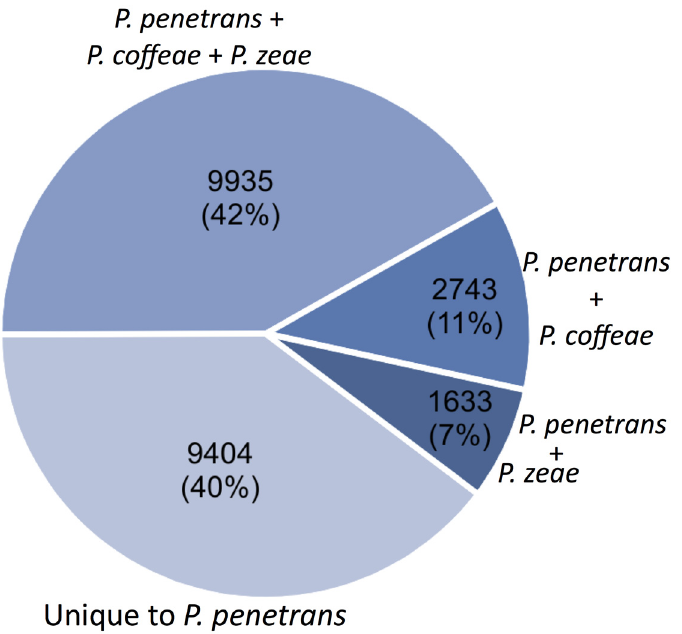
Fig 1. The number and percentage of Pratylenchus penetrans transcripts with similar sequences in related species. Using tBlastx ( E -value cutoff < 1e -5 ; and bitscore > 50), 40% of the P . penetrans transcripts are not represented in either the transcriptome of P . coffeae [10] or that of P . zeae [13]. P . penetrans transcripts will similar sequences in both, or one of the related species is